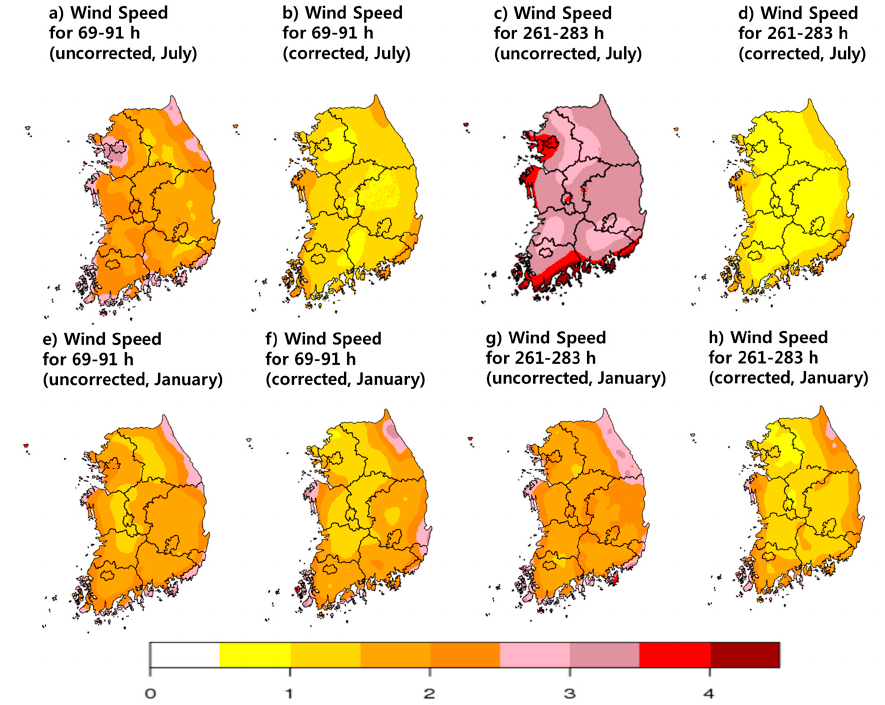
Figure 7. Spatial distributions of wind speed MAEs in July 2017 and January 2018. Results are for ( a )